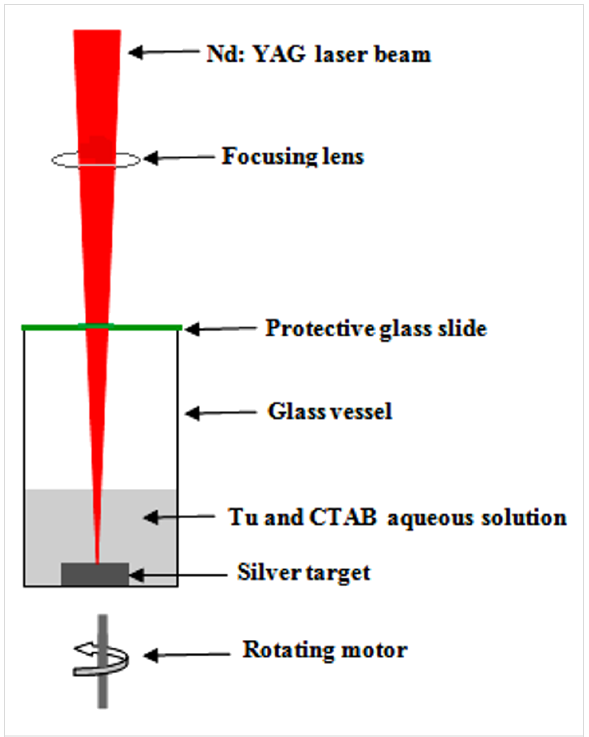
Figure 1: Schematic diagram of PLAL system used for preparation of Ag 2 S